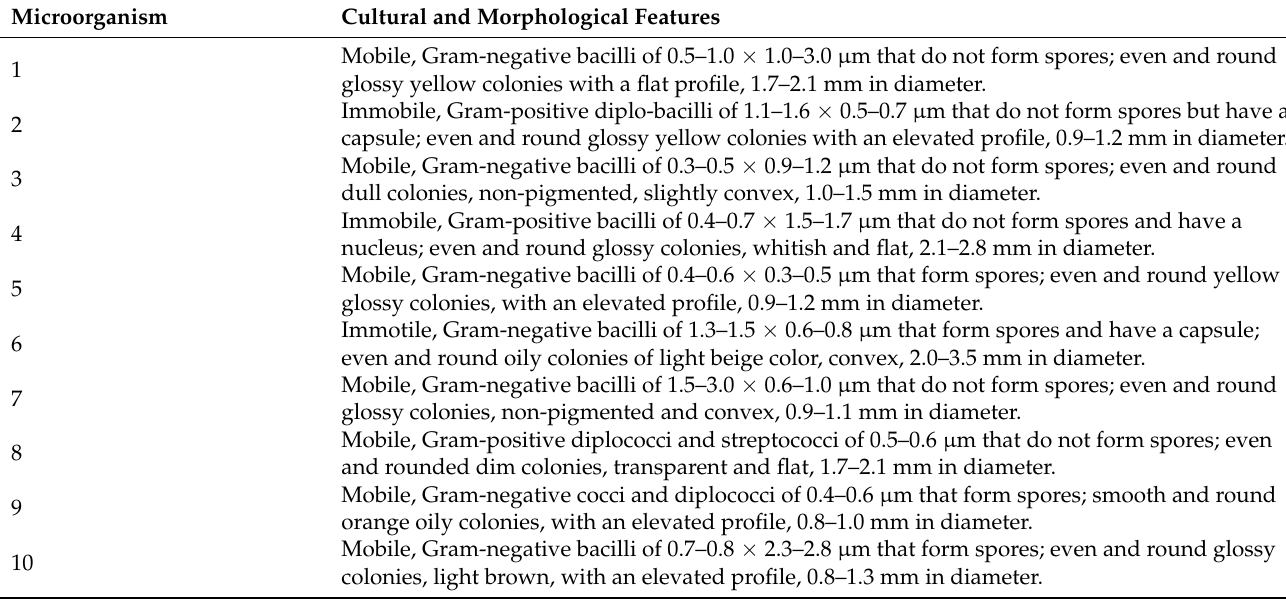
Table 1. Cultural and morphological profile of microorganisms.